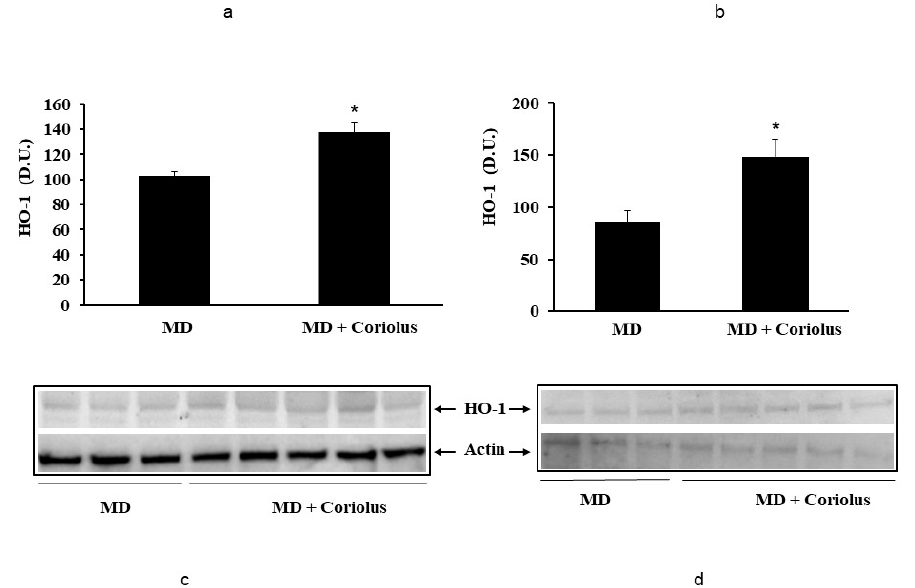
Figure 3. Heme oxygenase-1 levels in lymphocytes and in plasma from MD patients. Samples from MD patients were assayed for heme oxygenase-1 (HO-1) by western blot as described in Materials and Methods. A representative immunoblot is shown. β -actin has been used as loading control ( c , d ). The bar graph shows the densitometric evaluation ( a , b ) and values are expressed as mean ± SEM of independent analyses on 22 patients (MD plus Coriolus biomass) and, respectively, on 18 patients (MD alone), per group. * p < 0.05 vs. MD alone. D.U., densitometric units.